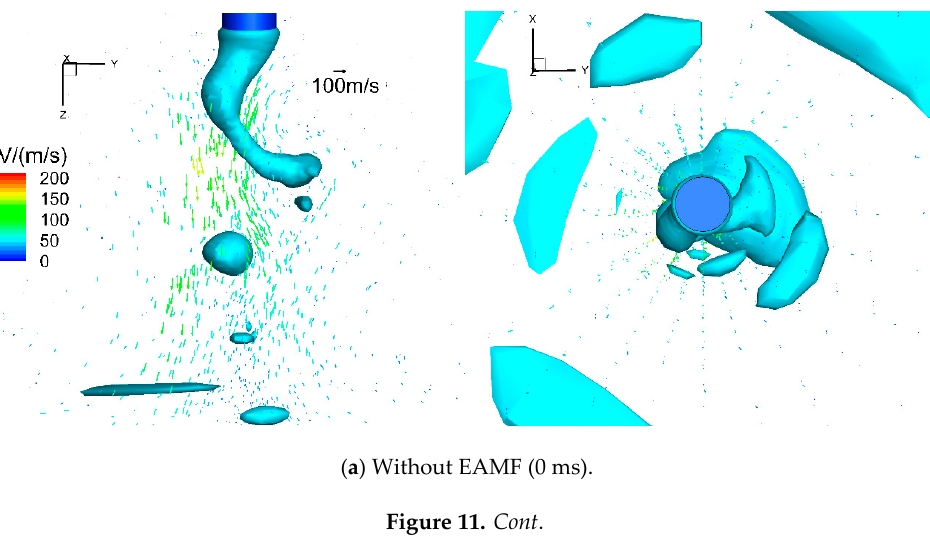
Figure 10. Maximal arc temperature and flow velocity in high-current GMAW with EAMFs at different alternating